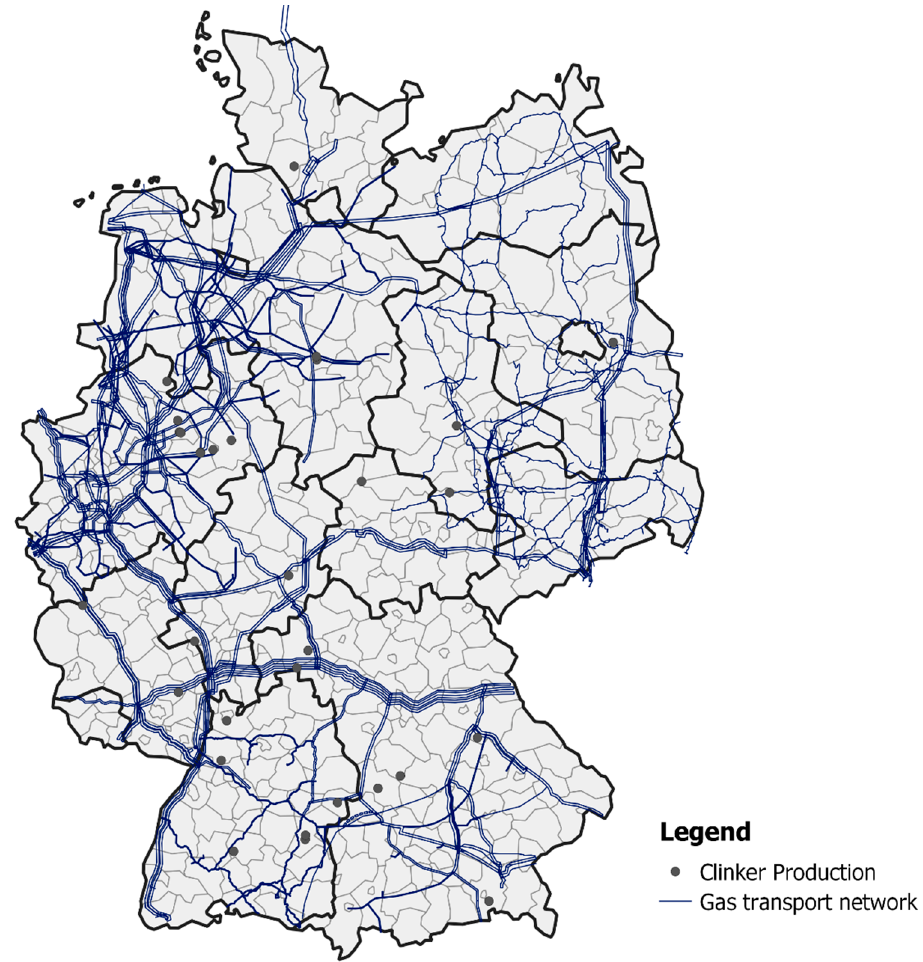
Figure 7. Cement production sites including clinker production in combination with the current gas transportation network. Based on [26,34] and updated from [27].